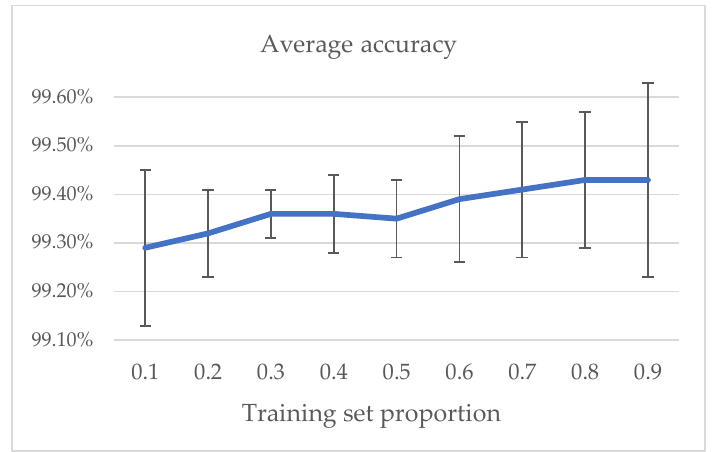
Figure 10. The average accuracy of different validation methods on the LFW test set.